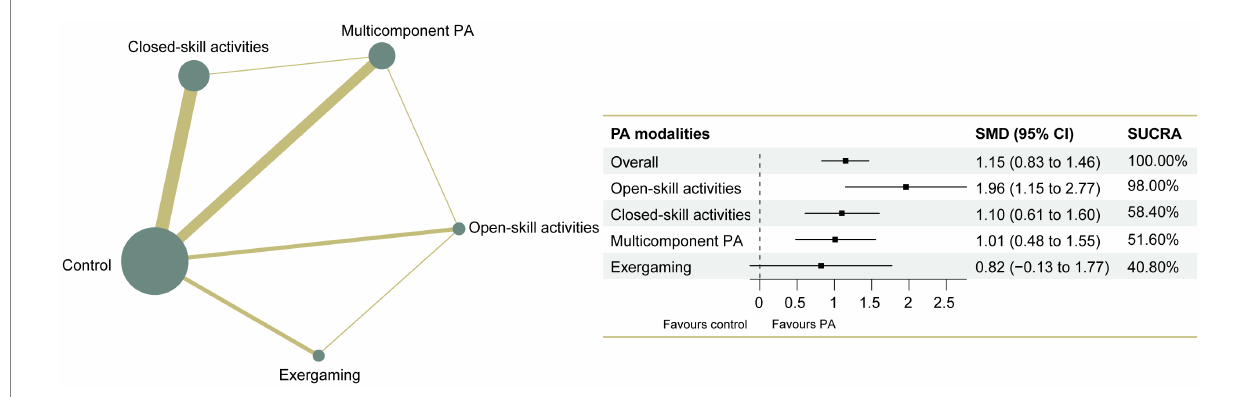
FIGURE 2 Network plot of comparisons and the efficacy of varied treatments compared with the control group for executive functions. Each node represents an intervention and its size depends on the number of participants. The connecting lines between 2 nodes represents 1 or more trials in which the 2 interventions have been compared directly. The thickness of the lines connecting 2 nodes is weighted according to the number of trials that directly compared the interventions it connected. PA, physical activity; SMD, standardized mean difference; SUCRA, the surface under the cumulative ranking curve.